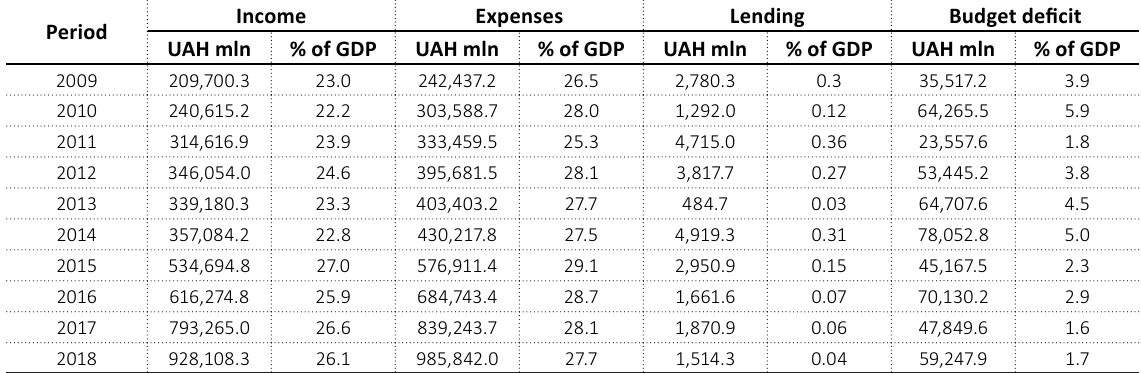
Table 2. Execution of the government budget of Ukraine, UAH